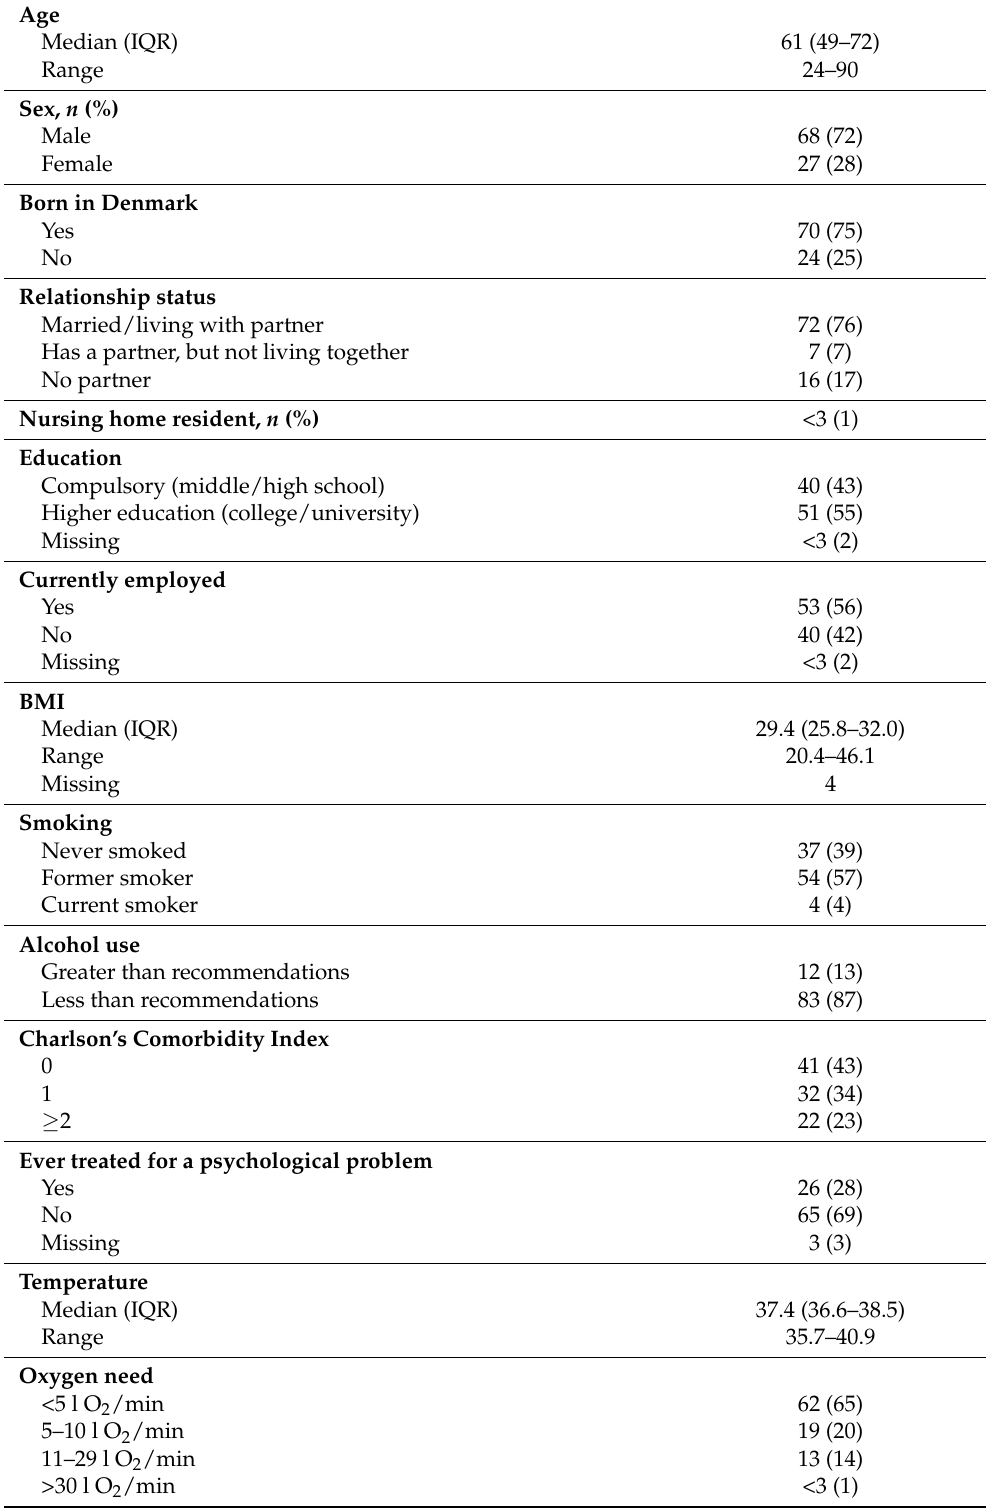
Table 1. Patient characteristics at hospital admission ( n =